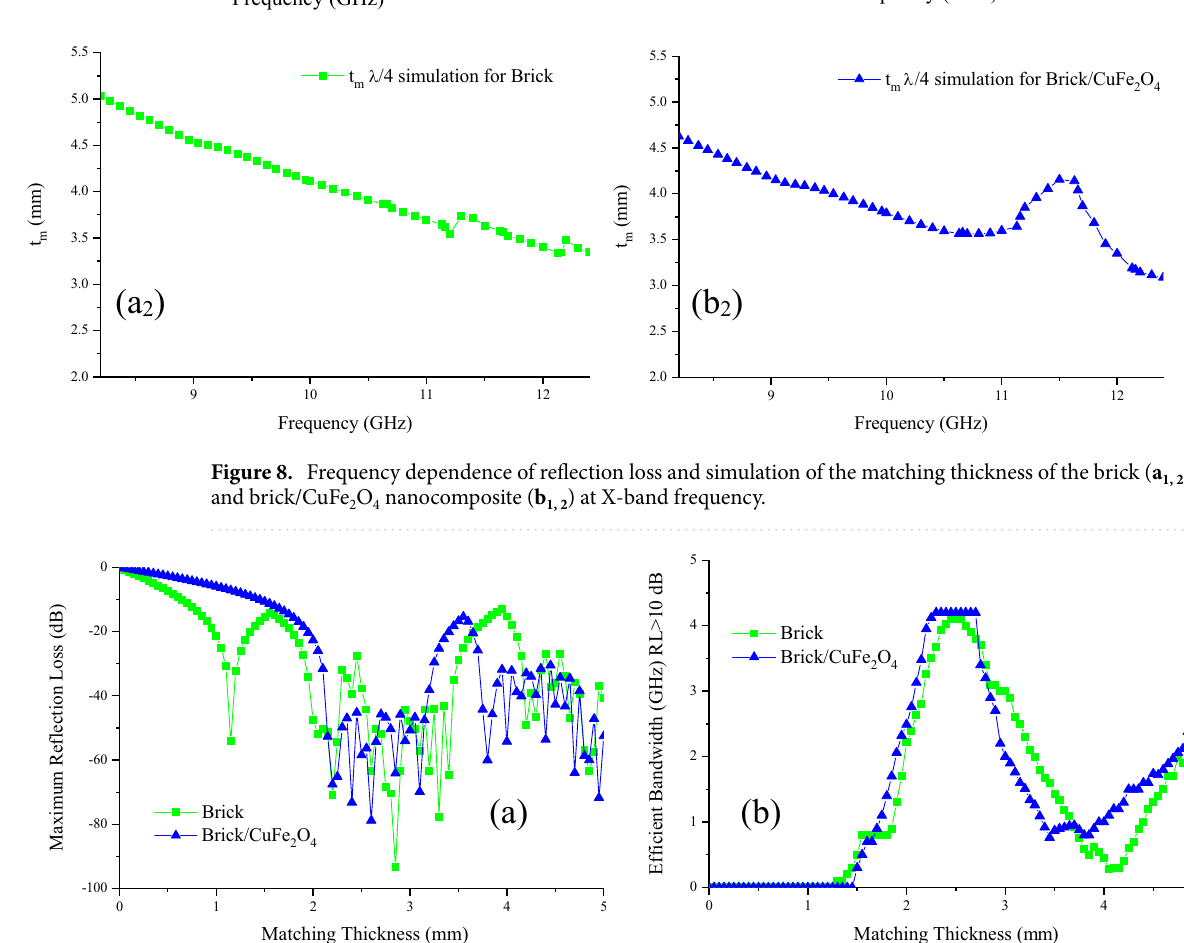
Figure 9. Matching thickness versus maximum reflection loss ( a ) and efficient bandwidth ( b ) of the